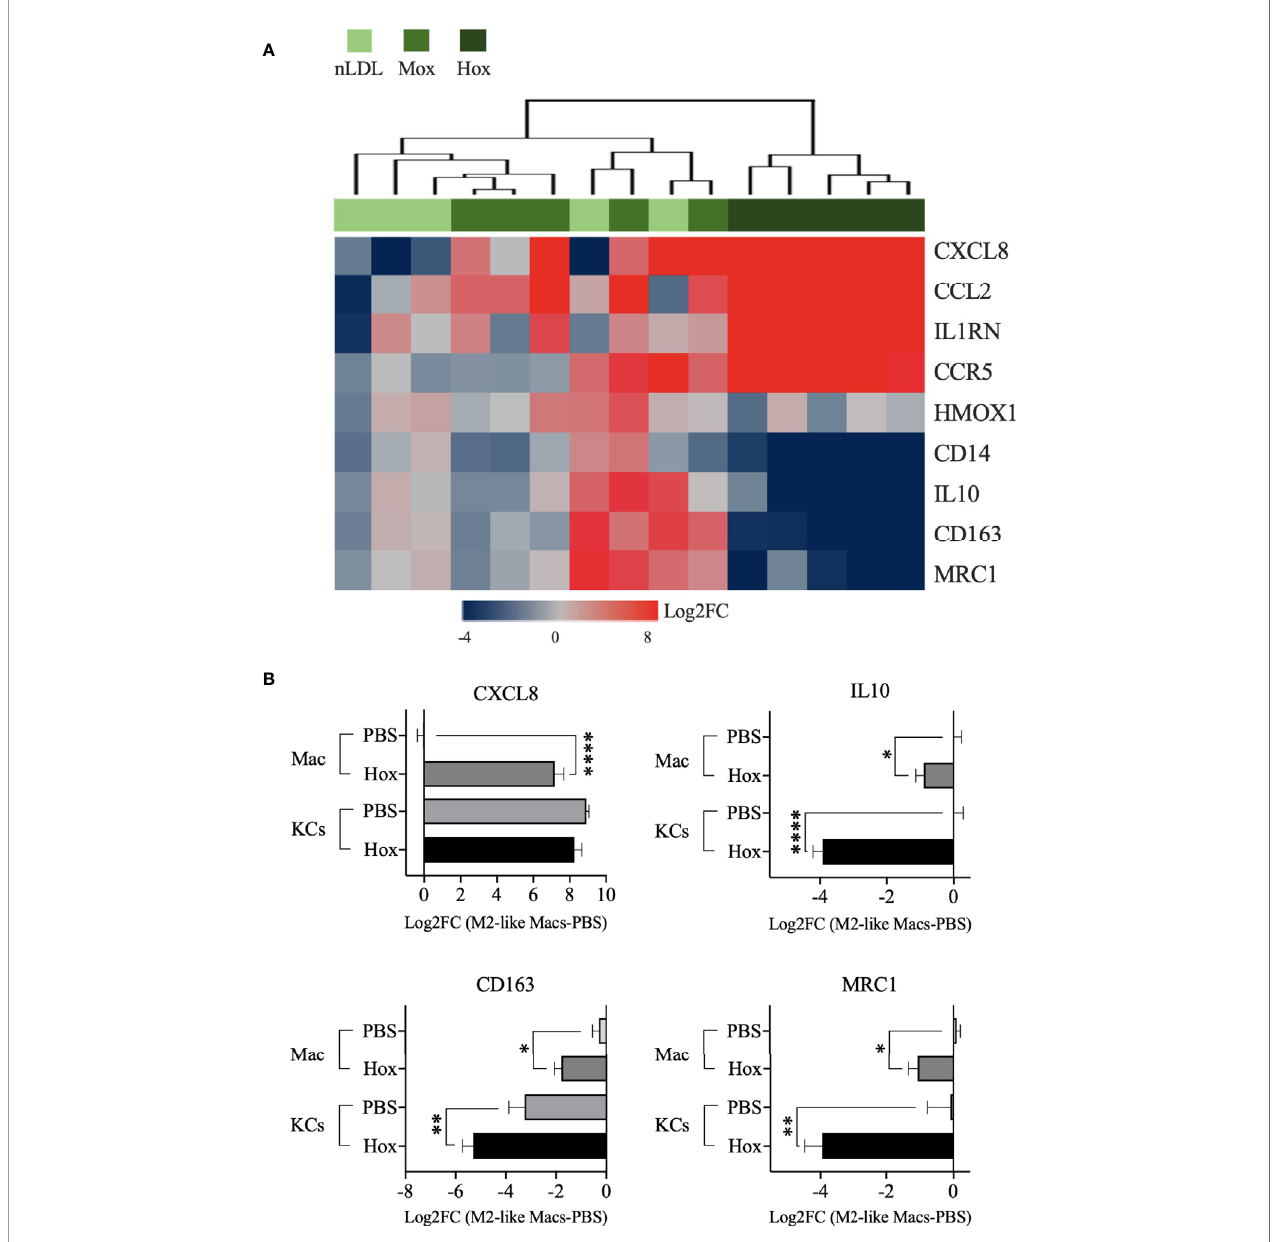
FIGURE 3 | M2-like macrophages and Kupffer cells stimulated by HoxLDL switch to the M4-like proin fl ammatory phenotype. (A) Heatmap displays the M4- biomarkers expressed by M2-like macrophages exposed to nLDL, MoxLDL, and HoxLDL (values = Log2FC compared to PBS, n=5 ). Genes from the HoxLDL group follow the M4 pro fi le, with upregulation of CXCL8, CCL2, CCR5, and IL1RN, and downregulation of CD14, CD163, HMOX1, MRC1, and IL10, suggesting that M2- like macrophages stimulated by HoxLDL change into the proin fl ammatory M4 phenotype. All the genes are signi fi cantly changed in the HoxLDL group. (B) Among the M4 biomarkers, we measured the expression of CXCL8, IL10, CD163, and MRC1 in human KCs with and without HoxLDL stimulation. Compared to in vitro M2- like differentiated macrophages (n=5) , KCs (n=5) are high constitutive producers of CXCL8, not changing signi fi cantly after HoxLDL exposure. However, the other common KCs ’ markers were signi fi cantly downregulated after HoxLDL treatment, indicating that KCs may shift to the M4-like phenotype in the presence of HoxLDL as well. Data are presented as mean ± SEM. One way ANOVA test; *p <0.05, **p <0.01, ****p